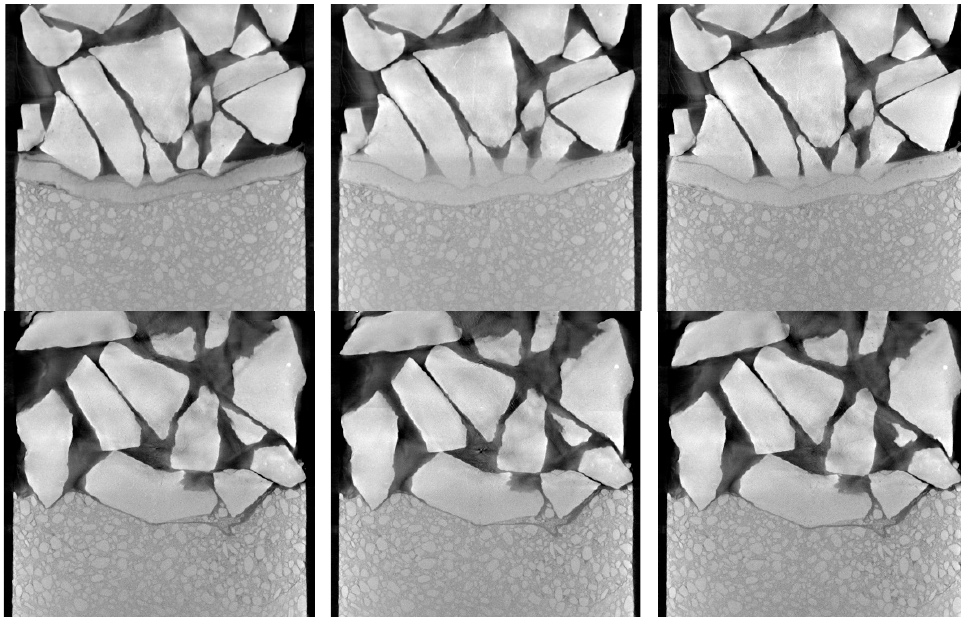
Figure 6. Typical test tube reconstructions with ( top row) and without ( bottom row) a CC layer. Different stages are shown from left (see the Section 2.1 above Figure 4, point #2), through middle (see the Section 2.1 above Figure 4, point #5) to right (see the Section 2.1 above Figure 4, point #8).